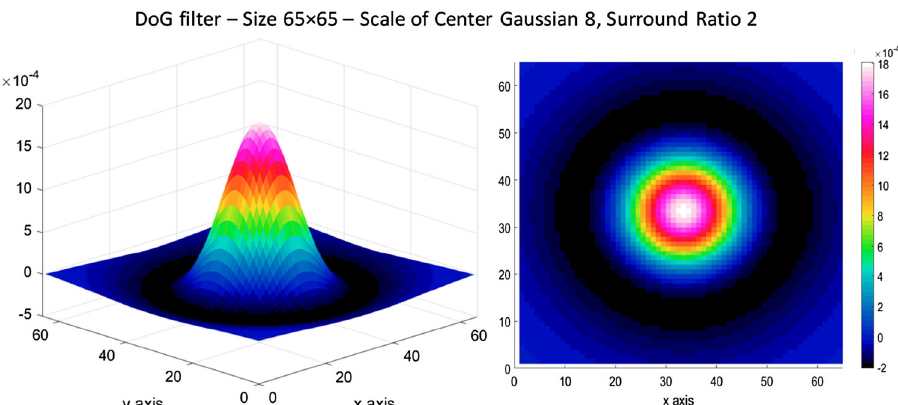
Fig. 2 Left 3D surface of a Difference of Gaussian filter with the scale of the centre Gaussian equal to 8 ( r c ¼ 8). The Surround ratio is s ¼ 2, and the Window ratio is h ¼ 8. Right Top view (2D) of the DoG filter. Window size is 65 9 65. Jet white colour map is used to display the graph. (Color figure